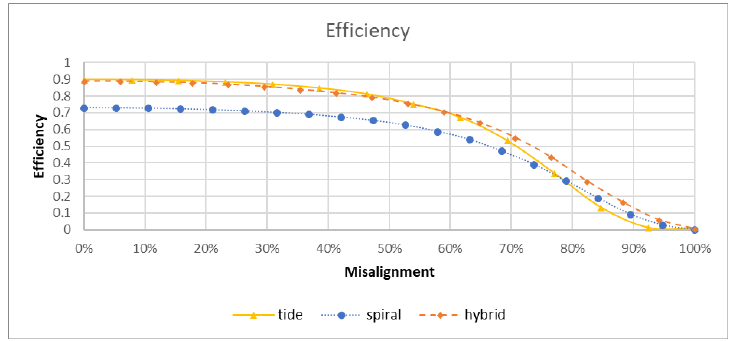
Figure 27 Figure 27. Measured efficiency for primary compensation with resistive